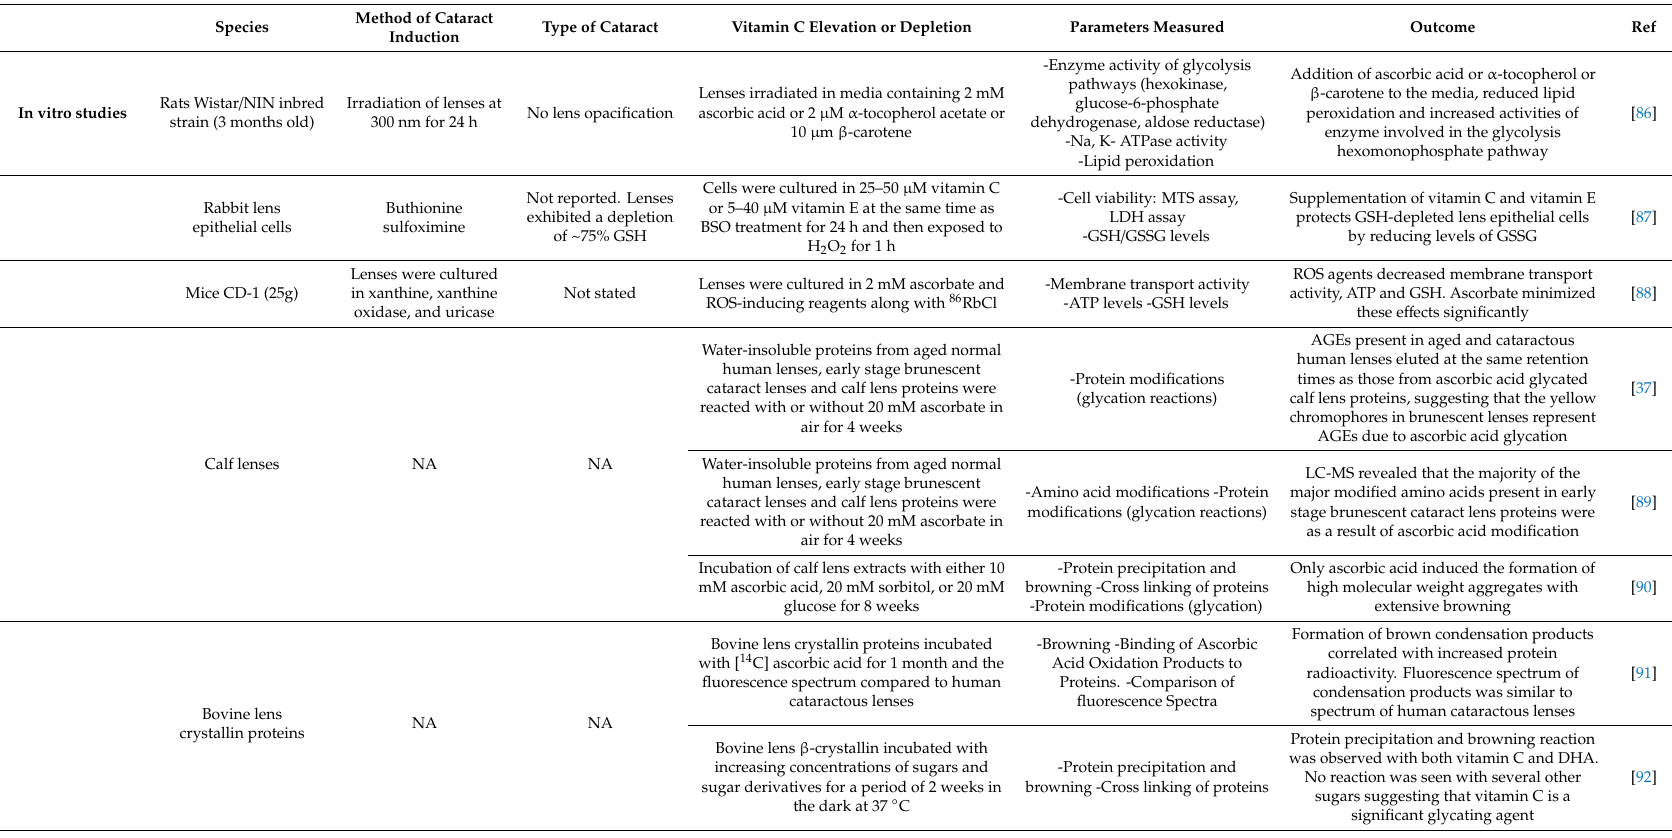
Table 1. Summary of animal studies and the e ff ects of dietary vitamin C supplementation or depletion of vitamin C on the